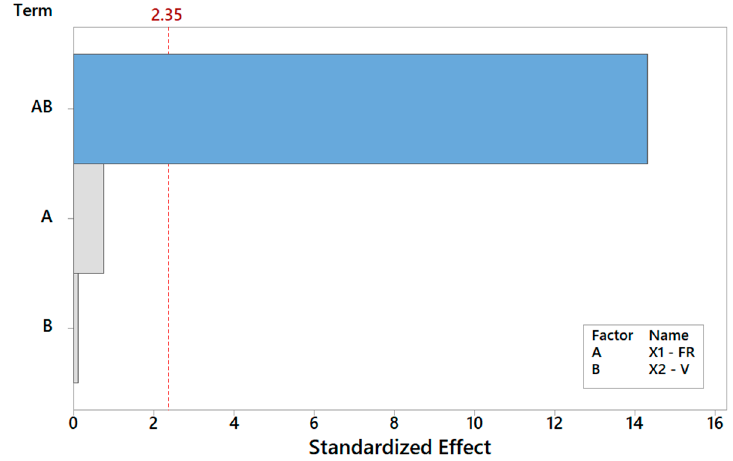
Figure 9. Pareto plot of standardized effects for Y 2 , rendering a visual ranking of their role on the spread of the FD. A gray bar represents a term not in the model.